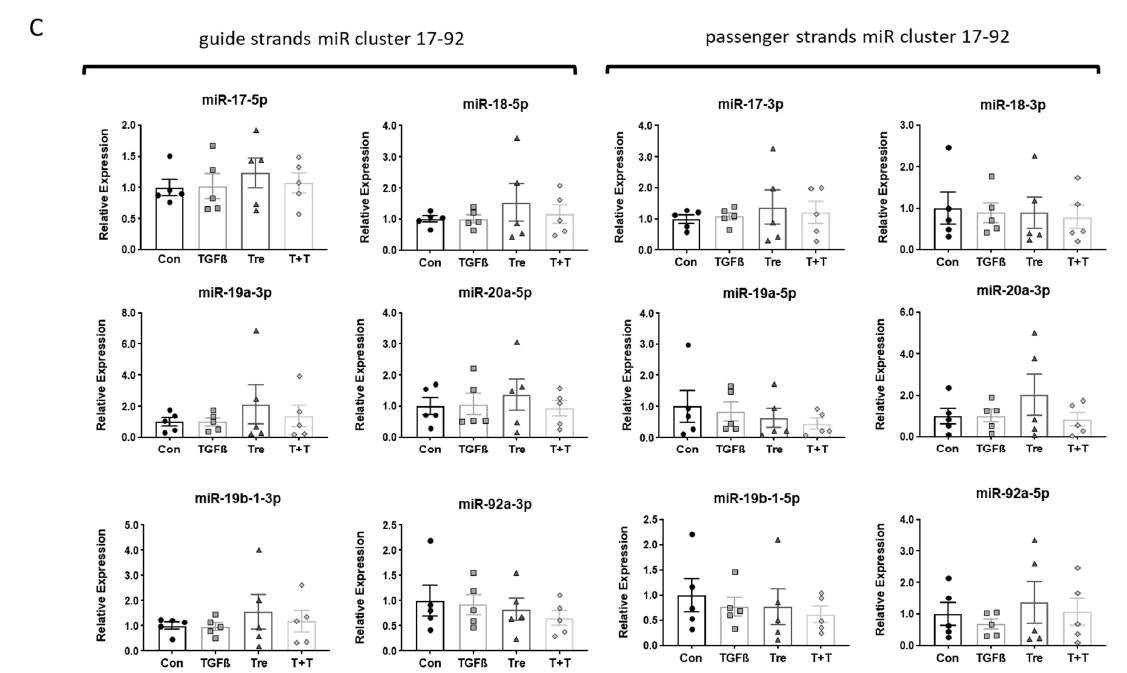
Figure 2. Disease-specific modification of miR17-92 expression by TGF- β 1 and treprostinil. Cells were treated with either TGF- β 1 (10 ng/mL), or treprostinil (10 − 8 M) alone, or combination of both (T + T). MiR expression was determined after 24 h for guide and passenger strands. Relative expression of miR17-92 in ( A ) cells of controls ( n = 7); ( B ) IPF patients ( n = 7); and ( C ) interstitial lung fibrosis patients ( n = 5). Bars represent mean ± SEM. * indicates p < 0.05. TGF β : TGF- β 1 (10 ng/mL); Tre: treprostinil (1 × 10 –8 M); T+T: TGF- β 1 (10 ng/mL) plus treprostinil (1 × 10 –8 M).